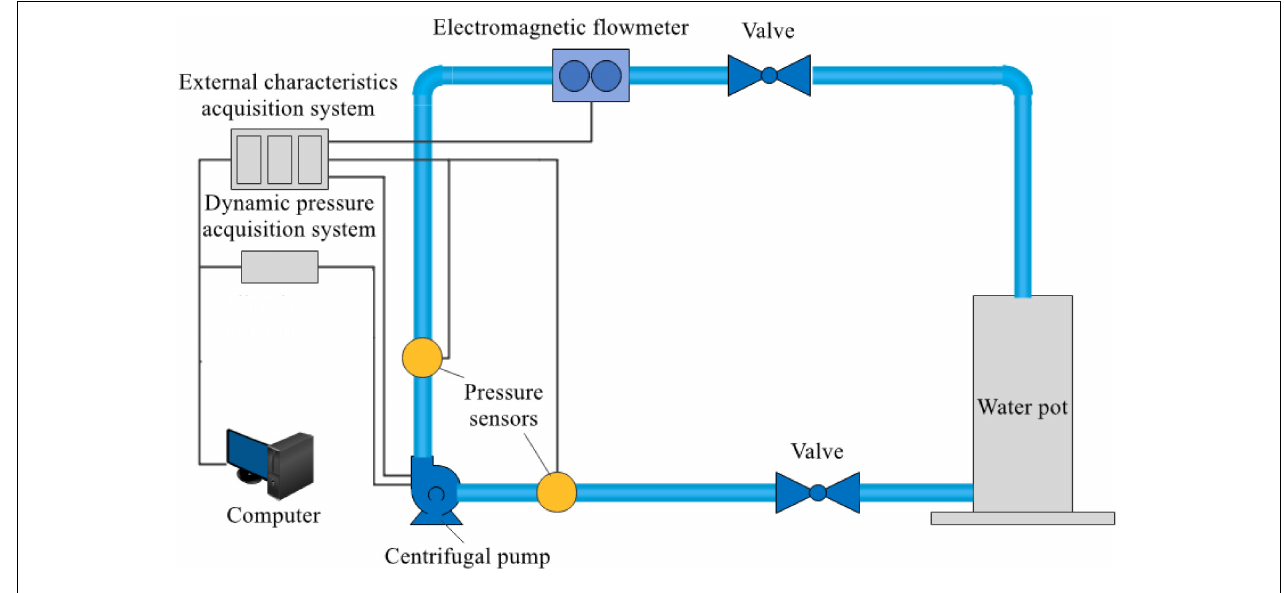
FIGURE 4 | Testing system of the centrifugal